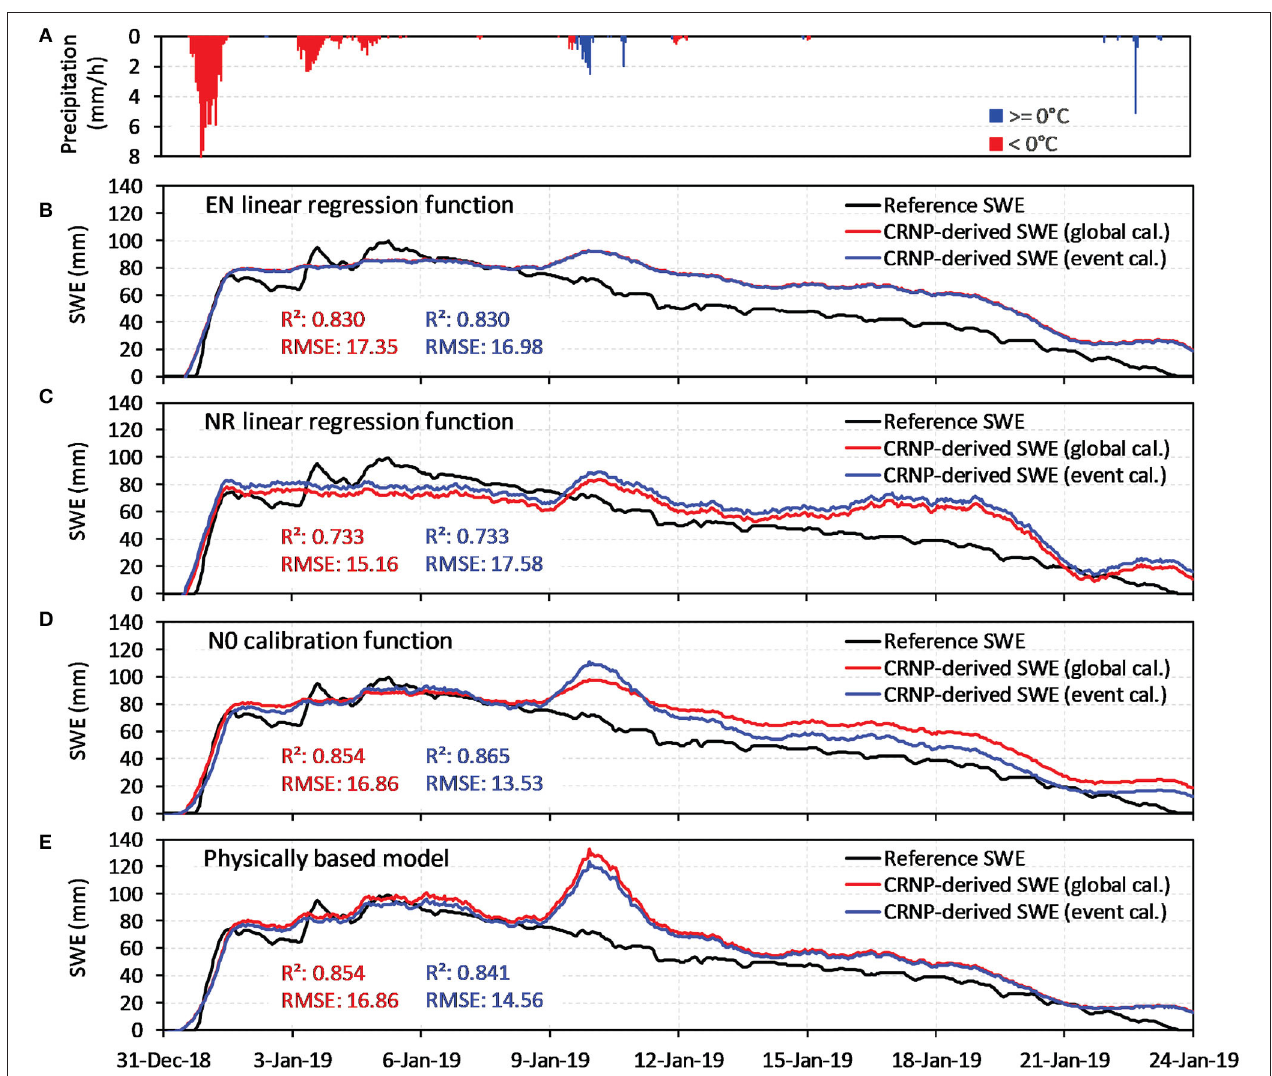
FIGURE 10 | Comparison of two parameterizations of (B) the epithermal regression function, (C) the neutron ratio regression function, (D) the N 0 function, and (E) the physically based model for a snow event in winter 2018/19. For the global calibration the 20 selected SWE reference values ( Figure 6 ) were used and for the event calibration SWE data from the first 6 days of this snow event were used. Precipitation intensities for freezing and non-freezing conditions are also shown (A)